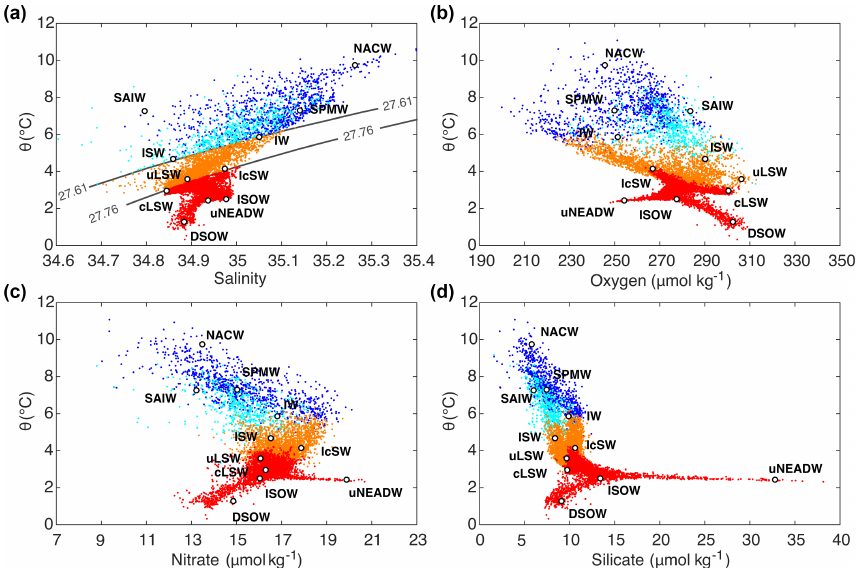
Figure 2. Source water type (SWT) parameters presented in a potential temperature: (a) salinity, including potential density ( σ 0 ) levels, (b) oxygen, (c) nitrate and (d) silicate space for Irminger Sea cruise data from 1991–2015. The colours represent different mixing figures for the eOMP analysis: red for the deep ocean ( σ 0 ≥ 27.76kgm − 3 ), orange for the intermediate ocean (27.61 ≤ σ 0 < 27.76kgm − 3 ) and surface ocean ( σ 0 < 27.61kgm − 3 ), east of Reykjanes Ridge (dark blue) and west of Reykjanes Ridge region